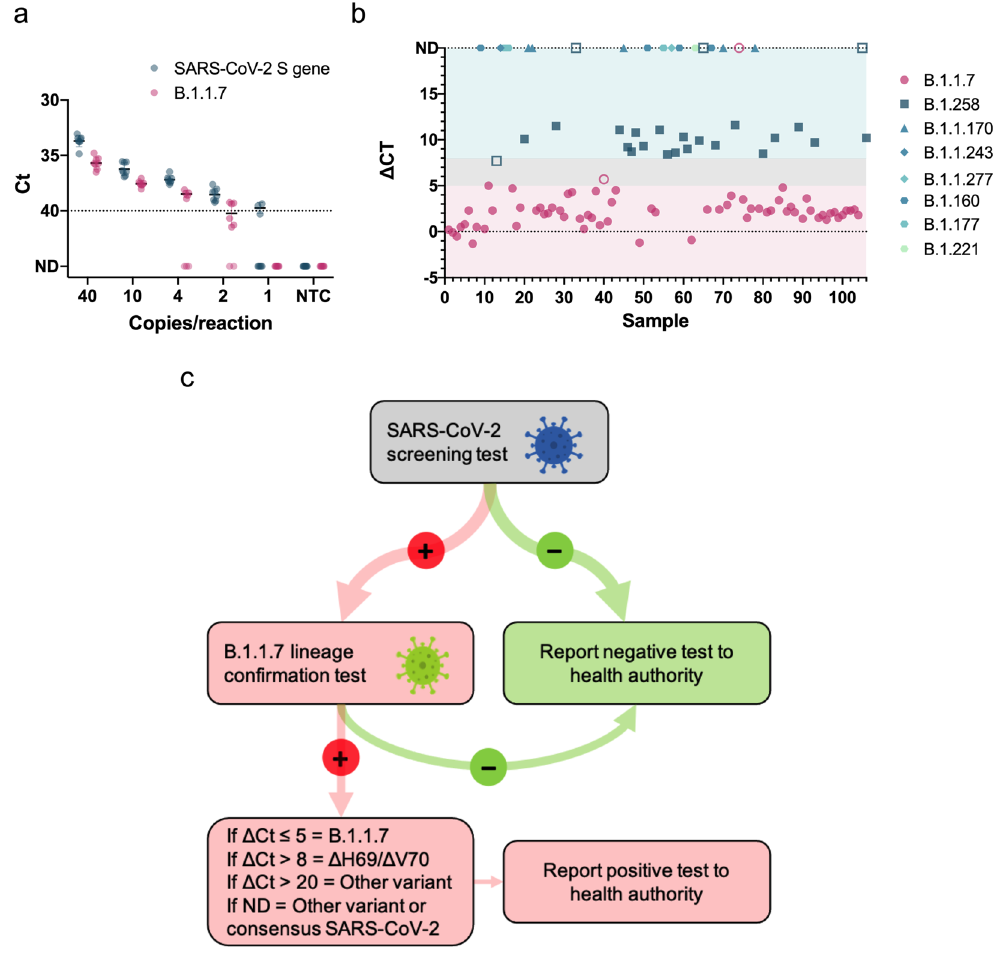
Figure 2. Analytical sensitivity and clinical validation of SARS-CoV-2 S gene and B.1.1.7 assays. ( a ) The limit of detection was determined for both SARS-CoV-2 S gene and B.1.1.7 assays by serial dilutions of isolated viral B.1.1.7 RNA. Data depict the mean and SD of eight replicates per each dilution. The dotted line at Ct 40 serves as a threshold after which amplification is considered invalid. ( b ) Overview of ΔCt values (= B.1.1.7 assay Ct— SARS-CoV-2 S gene assay Ct) for each sample in the clinical validation. Symbols represent the various SARS- CoV-2 lineages that were identified by sequencing. Closed symbols represent samples correctly identified by either the SARS-CoV-2 S gene or B.1.1.7 assays, whereas open symbols denote samples that did not meet the criterion established for variant identification. The shaded background shows ΔCt ranges that correspond with the criterion to report a sample as B.1.1.7 positive (pink), ΔH69/ΔV70 deletion positive (teal), and inconclusive (gray). ND, not detected. ( c ) Decision tree demonstrating the proper workflow, interpretation criterion, and actions to implement the SARS-CoV-2 S gene and B.1.1.7 assays in a testing regime to identify B.1.1.7 positive